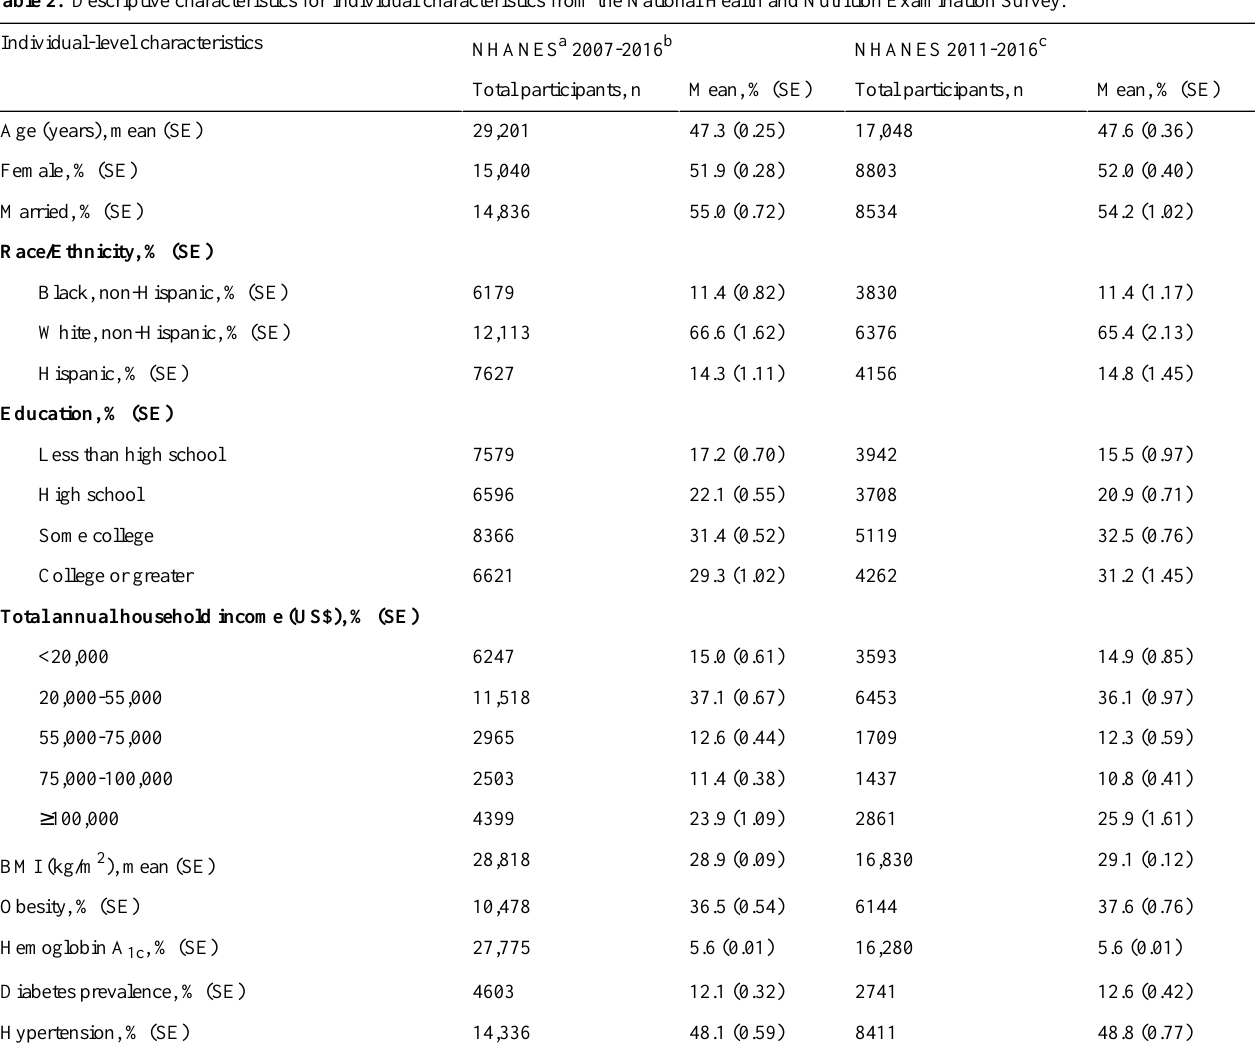
Table 2. Descriptive characteristics for individual characteristics from the National Health and Nutrition Examination